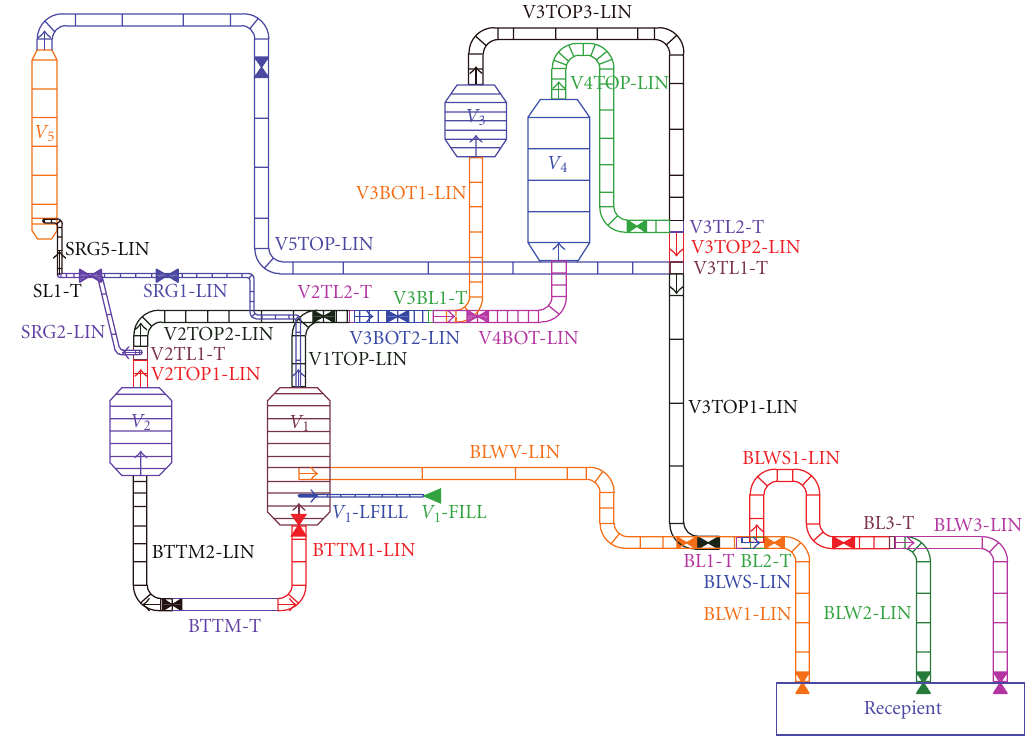
Figure 7: Nodalization scheme of the high-pressure